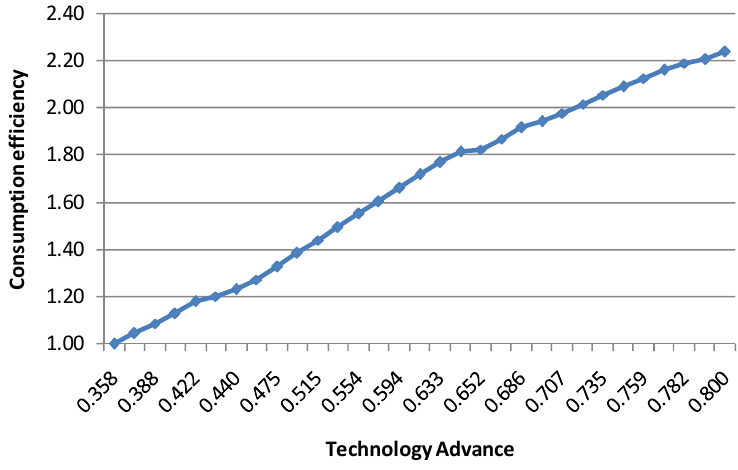
Figure 9. Relationships between the consumption efficiency and technological